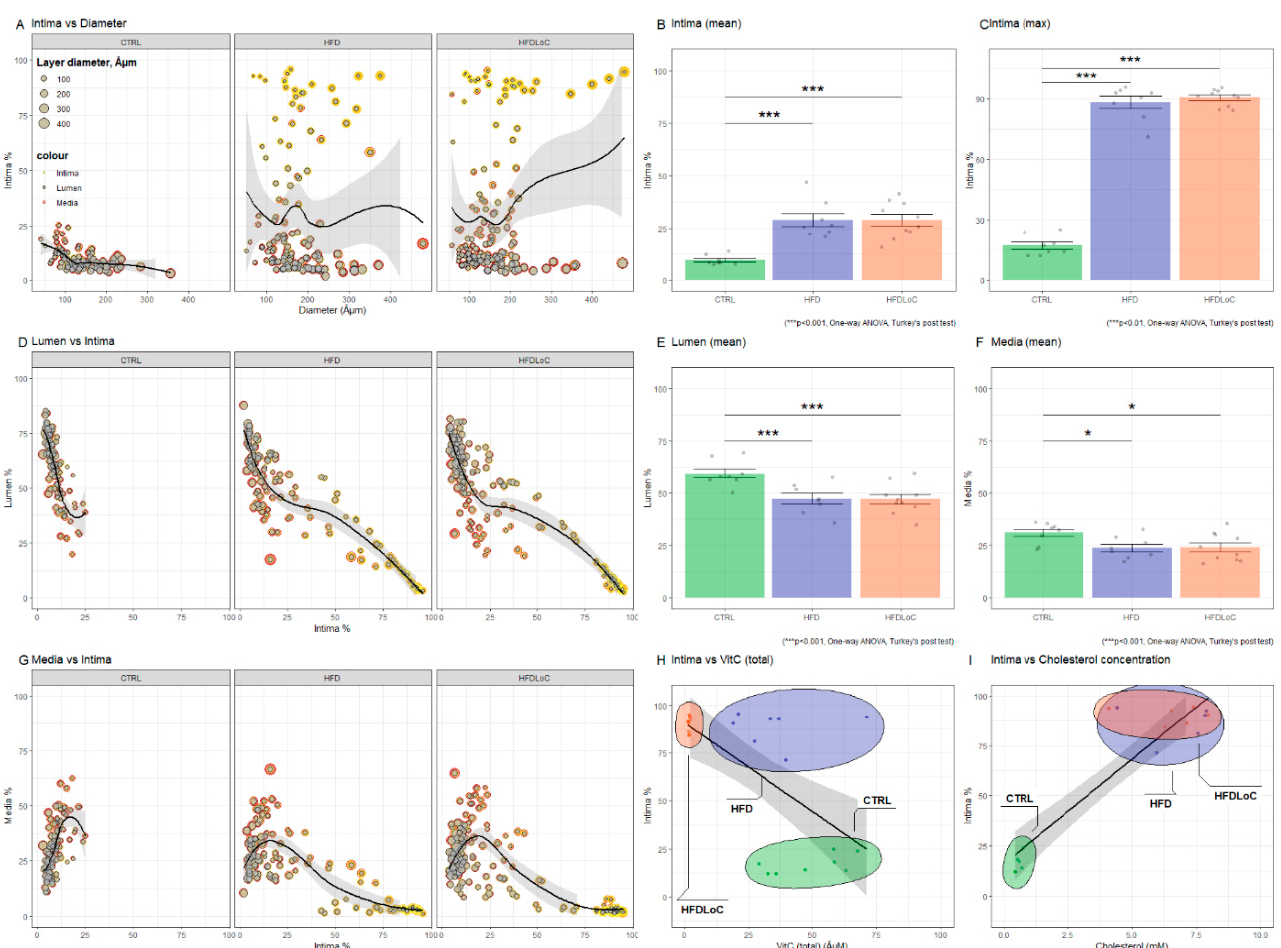
Figure 6. Quantification of intima, lumen, and media as percent of vessel diameter calculated from lamina elastic externa. ( A ) Intima % versus diameter shows increased intima (above approximately 25%) in coronary arteries from HFD and HFDLoC animals. ( B ) Average of all measured artery